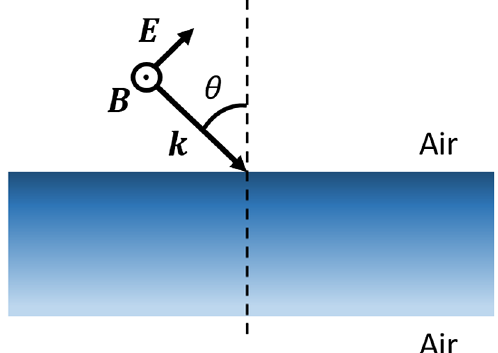
Fig. 1. Schematics of the studied geometry: a transverse magnetic mode impinging on a slab of highly doped semicon- ductor with an angle of incidence u . The simulated slab is assumed to be in air and 1 m m